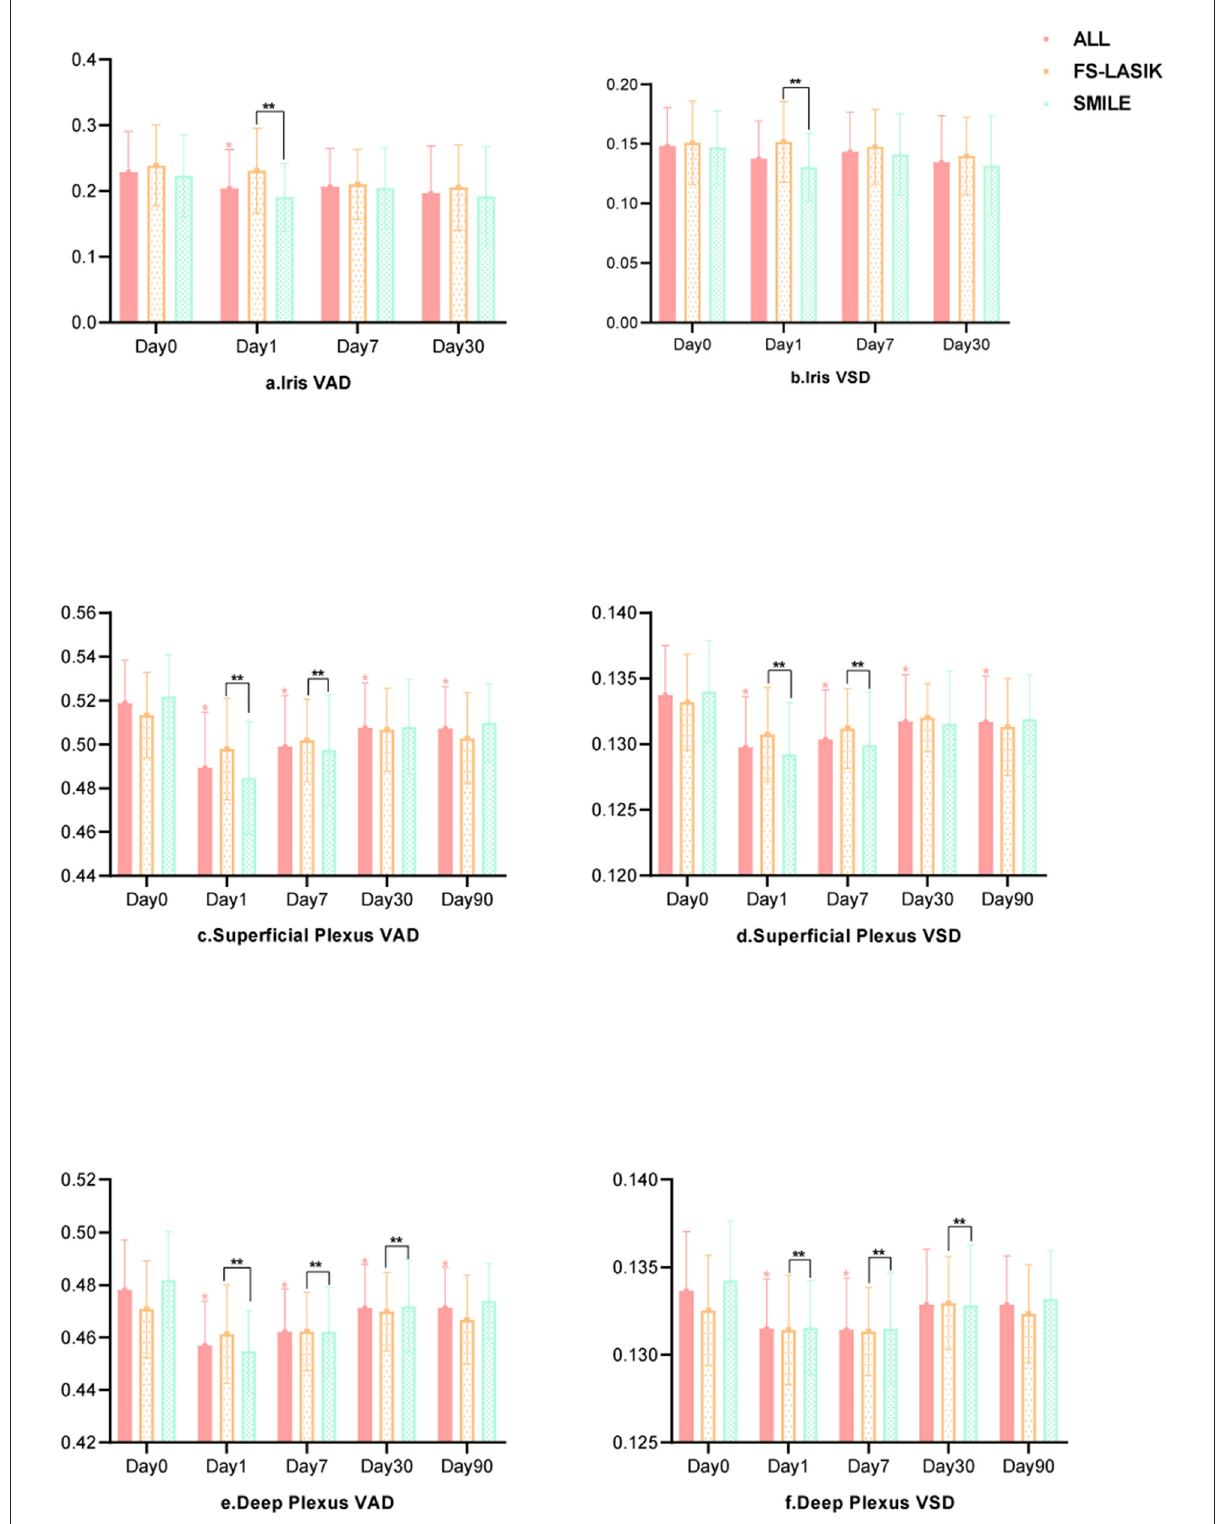
FIGURE2 The postoperative changes of the iris and retina blood flow